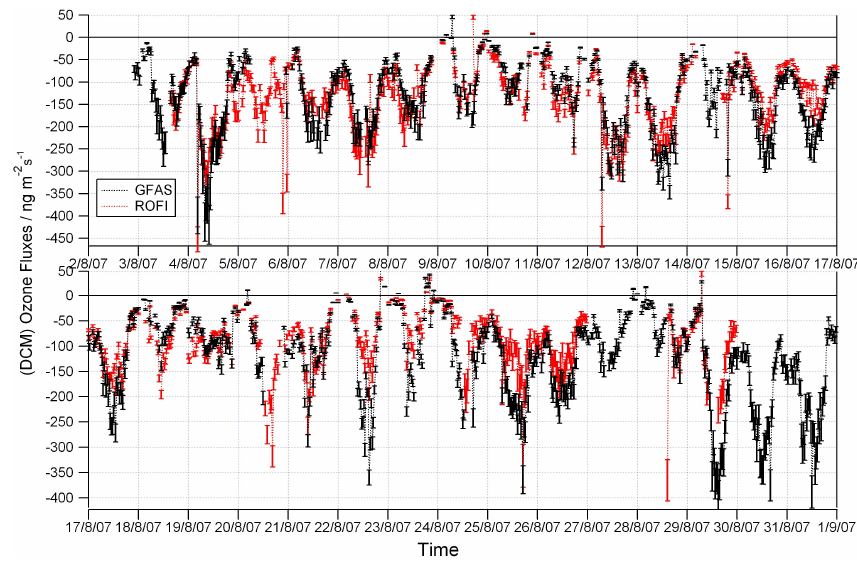
Fig. 4. Time series of fluxes by DCM for the GFAS and ROFI with error bars for the calculation method DCM. The top panel shows the time period from 2 August 2007 to 17 August 2007 and the bottom panel covers the period from 17 August 2007 to 1 September